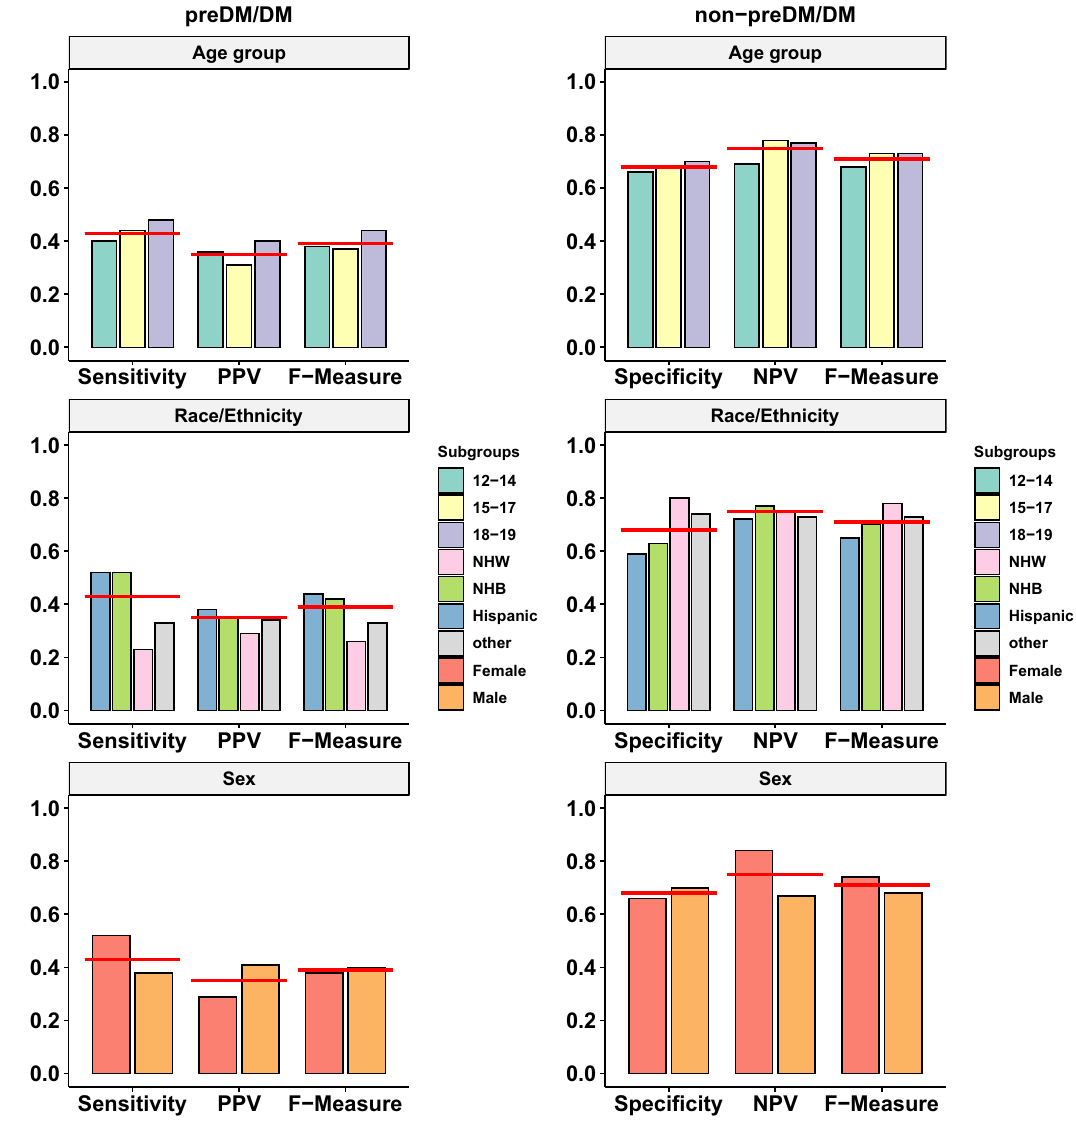
Figure 1. Variations in the performance of the American Diabetes Association pediatric screening guidelines in identifying youth with prediabetes/diabetes (preDM/DM) based on biomarker measurements across subgroups stratified by age group (12–14, 15–17, and 18–19), race/ethnicity (Hispanic, non-Hispanic Black, non-Hispanic White, other), and sex (female, male). Red lines denote the value of the corresponding evaluation measure obtained from the full study population (youth ages 12–19, National Health and Nutrition Examination Survey data, 2005–2016). preDM prediabetes; DM diabetes; F female; M male; Hisp Hispanic; NHB non-Hispanic Black; NHW non-Hispanic White; PPV positive predictive value; NPV negative predictive value. Results based on unweighted